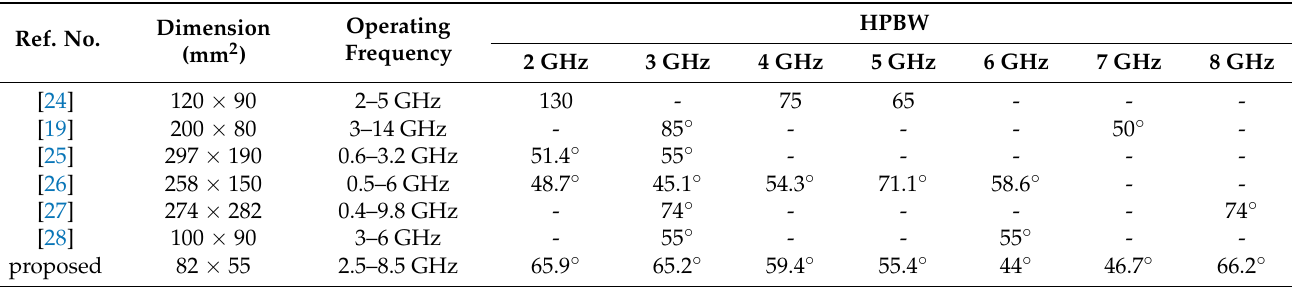
Figure 5. ( a ) Return loss of the simulated narrow beam Vivaldi antenna. ( b ) The gain of the simulated narrow beam Vivaldi antenna. Table 4. Comparison between proposed antenna and literature.